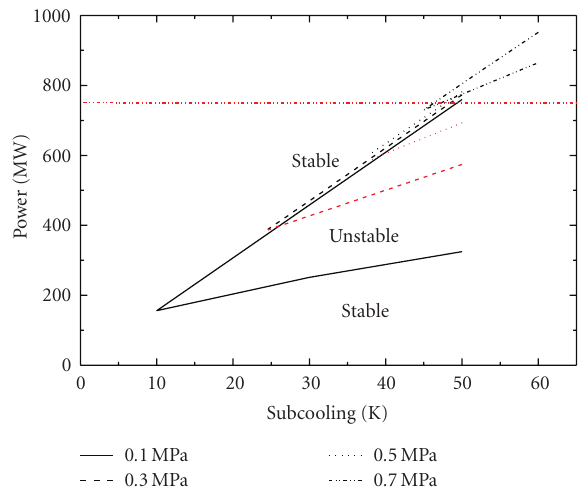
Figure 7: Characteristics of Ledinegg-type instability in NCS. Figure 8: Comparison between Ledinegg and flow pattern transi- tion instability maps for